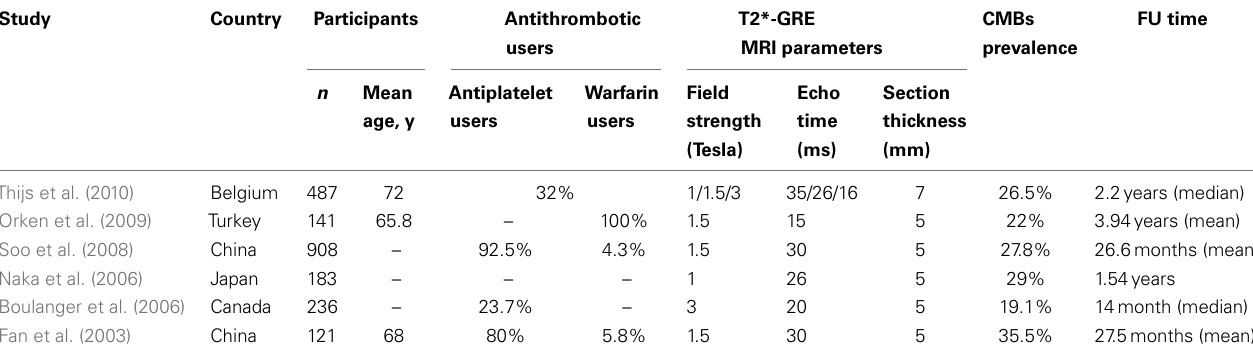
Table 3 | Characteristics, study design and methodological aspects of the main prospective cohort studies which have assessed the risk of future intracerebral hemorrhage in relation to the presence of cerebral microbleeds (CMBs).